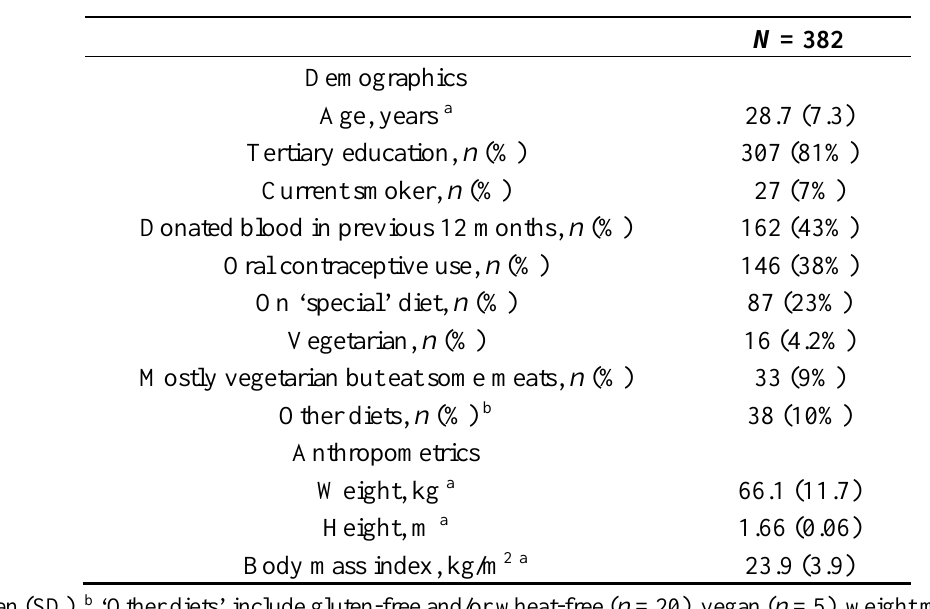
Table 2. Demographic and anthropometric characteristics of 382 women who participated in the